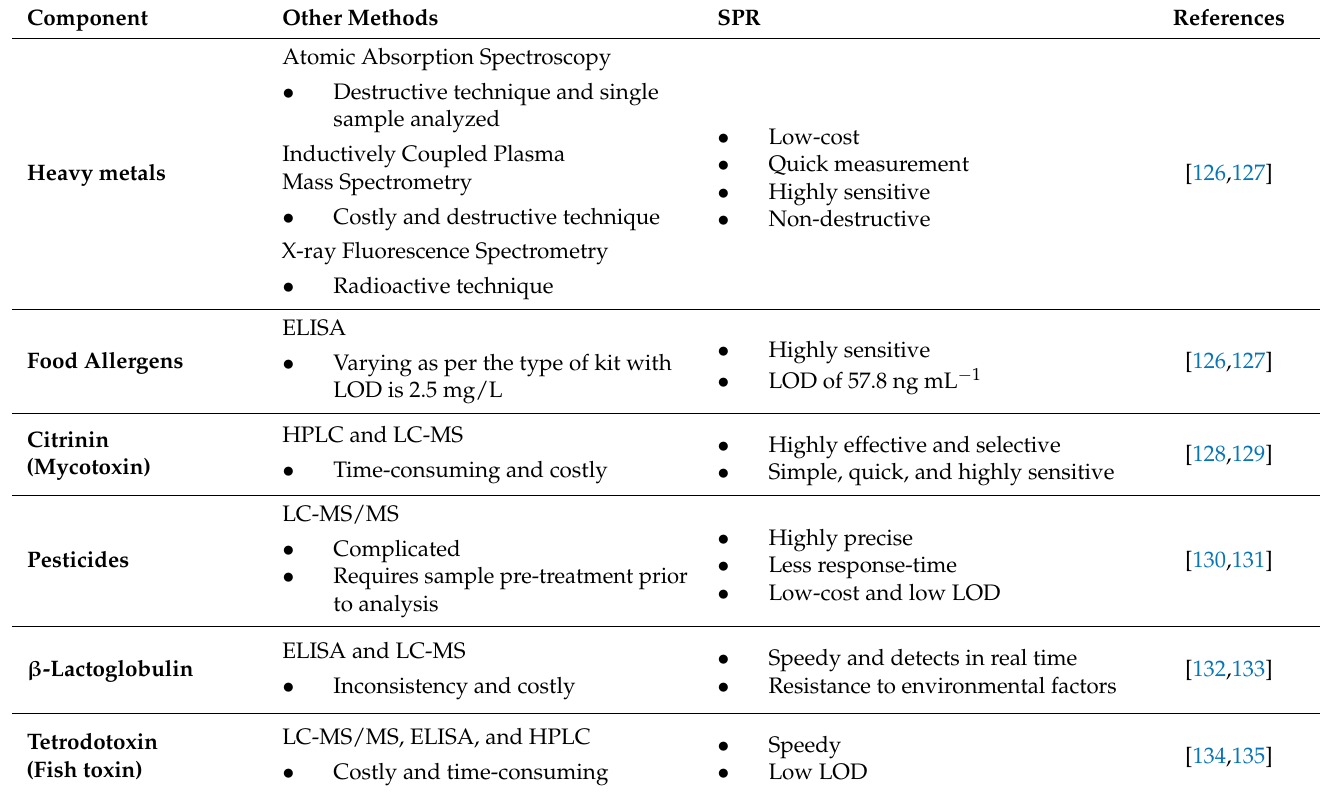
Table 2. SPR in comparison to other techniques for monitoring